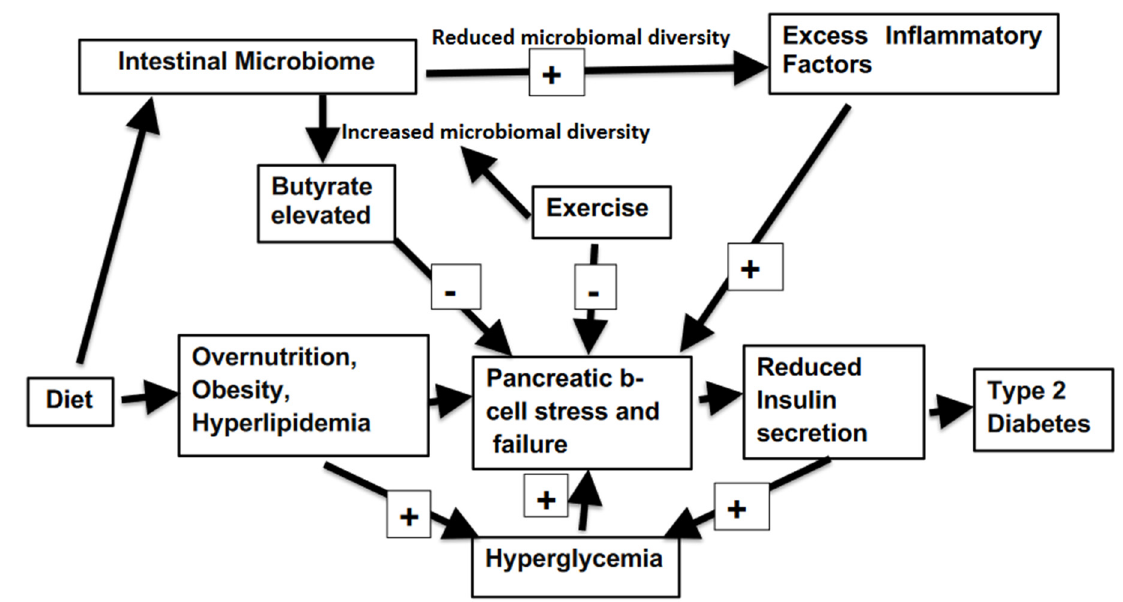
Figure 1. Factors influencing microbiomal interaction with diabetes progression.